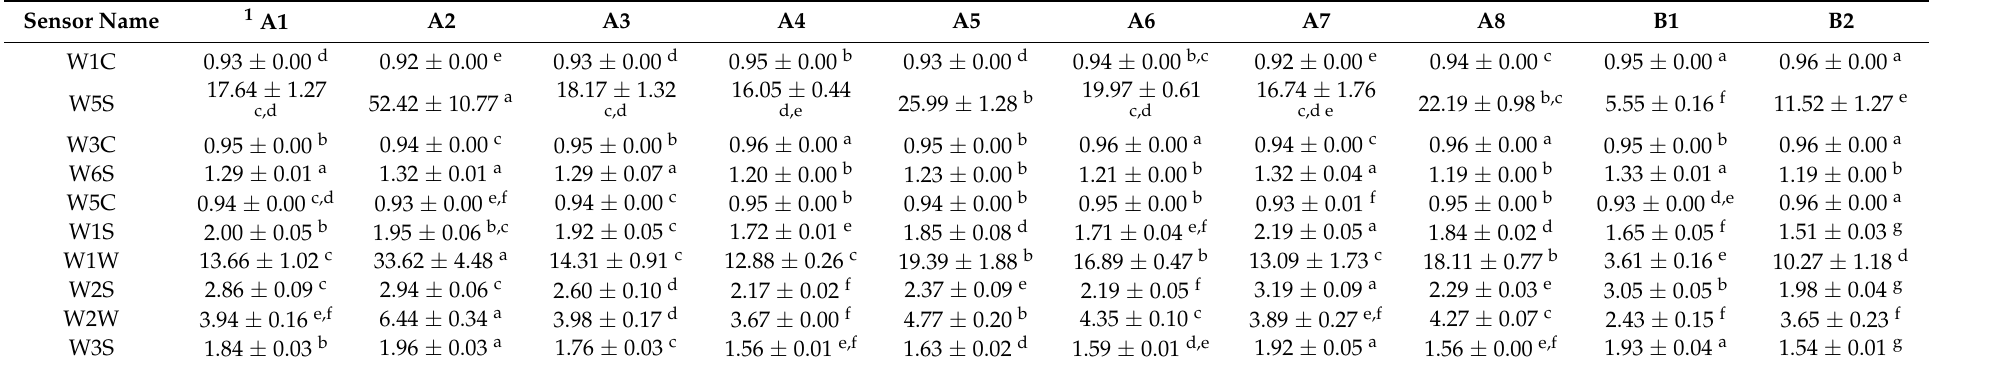
Table 5. Electronic nose sensor responses to volatile substances formed in different beef bouillons.